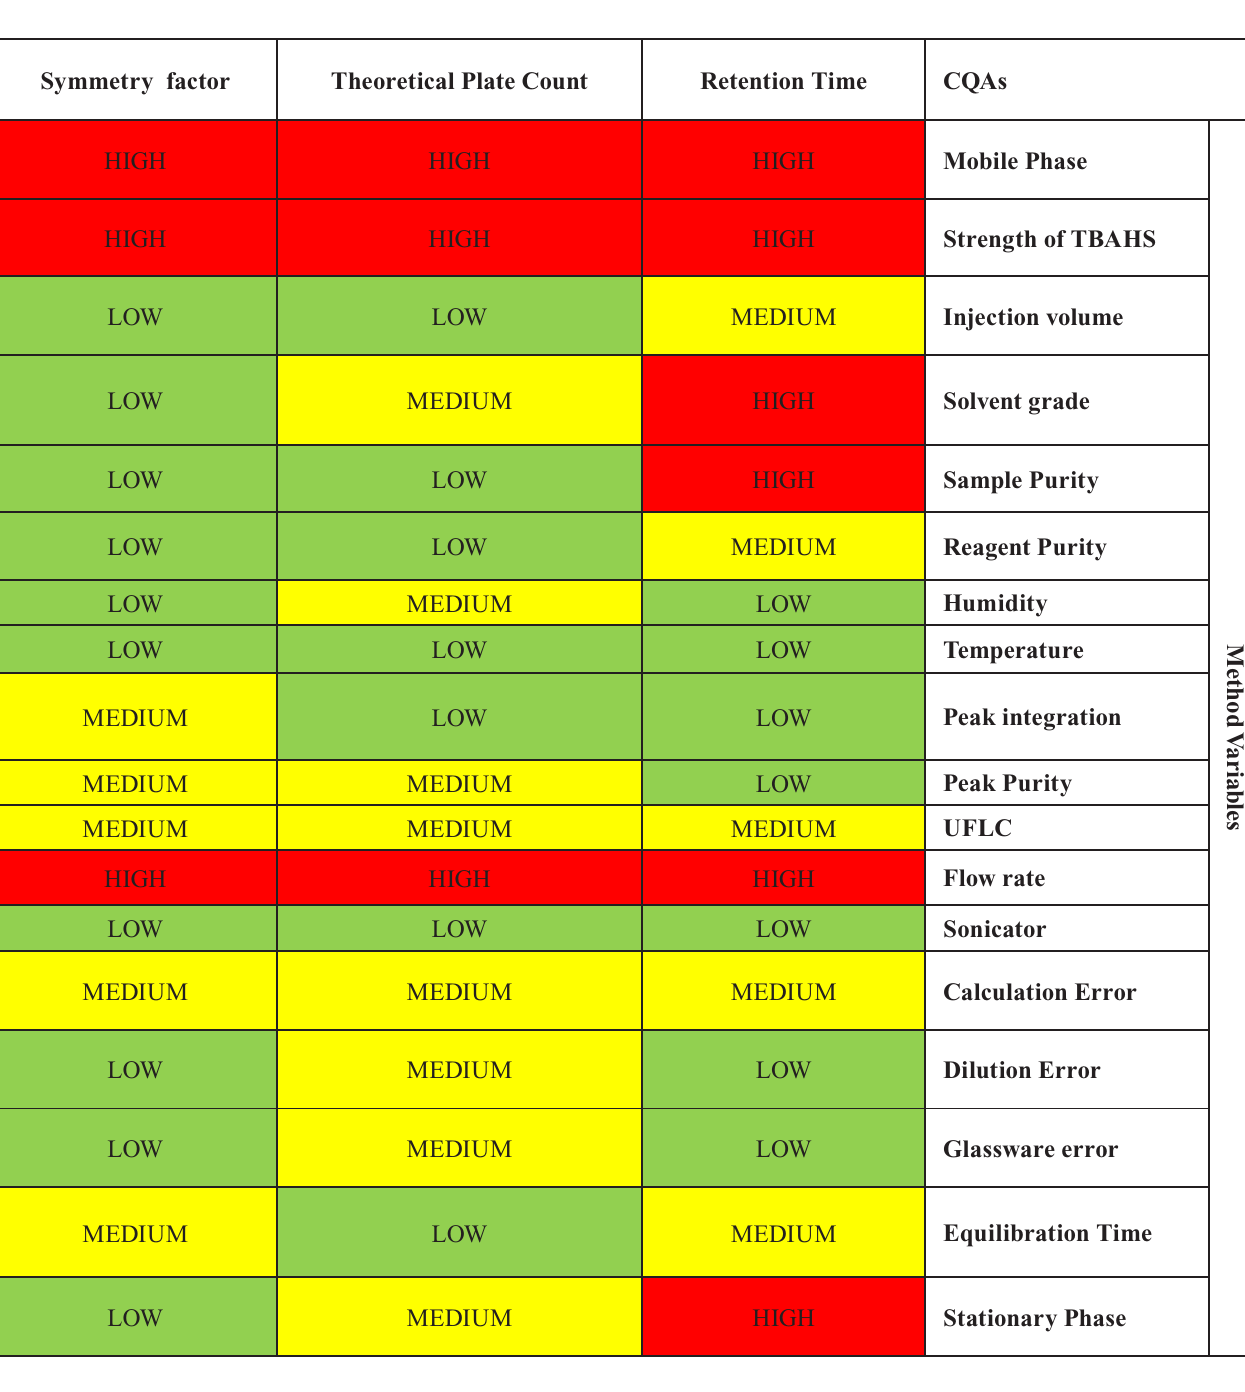
TABLE I - T raffic light risk analysis